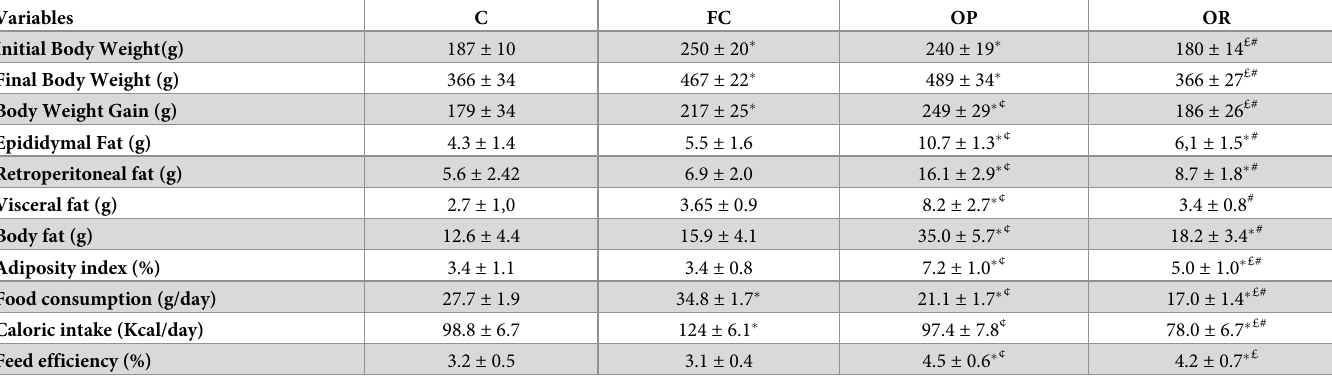
Table 1. Characterization of resistance to